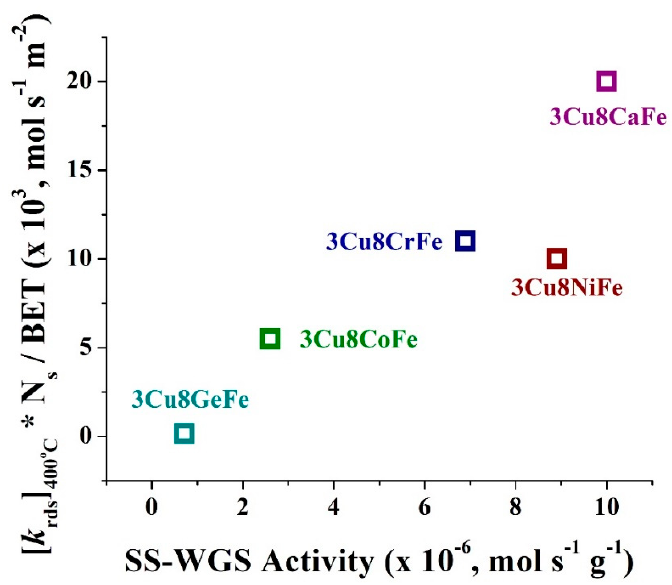
Figure 5. The plot of [ k rds ] 400 ◦ C * N s / BET vs. SS-WGS activity for the 3Cu8MFe catalysts (M = Cr, Ca, Ni, Co, and Ge).